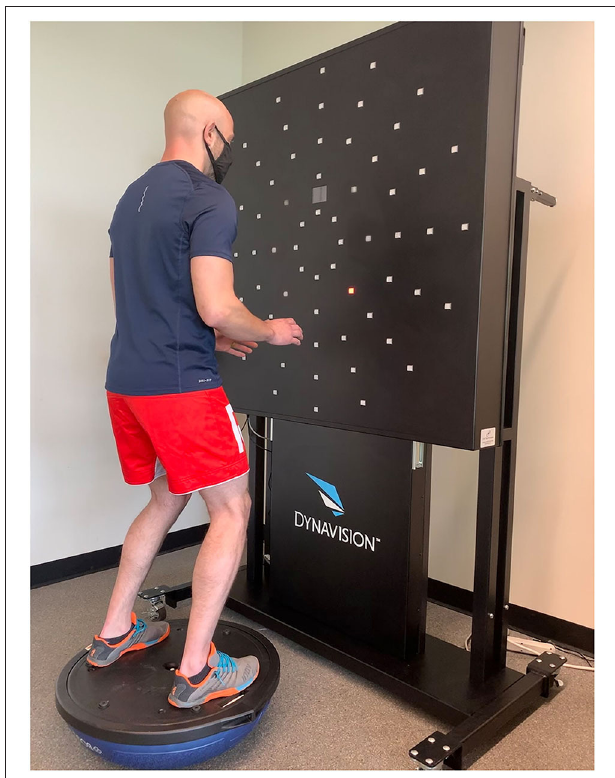
FIGURE 1 | Physical conditions during balance tasks. Participants were positioned in front of the Dynavision D2 board atop a Bosu Ball for two of the five